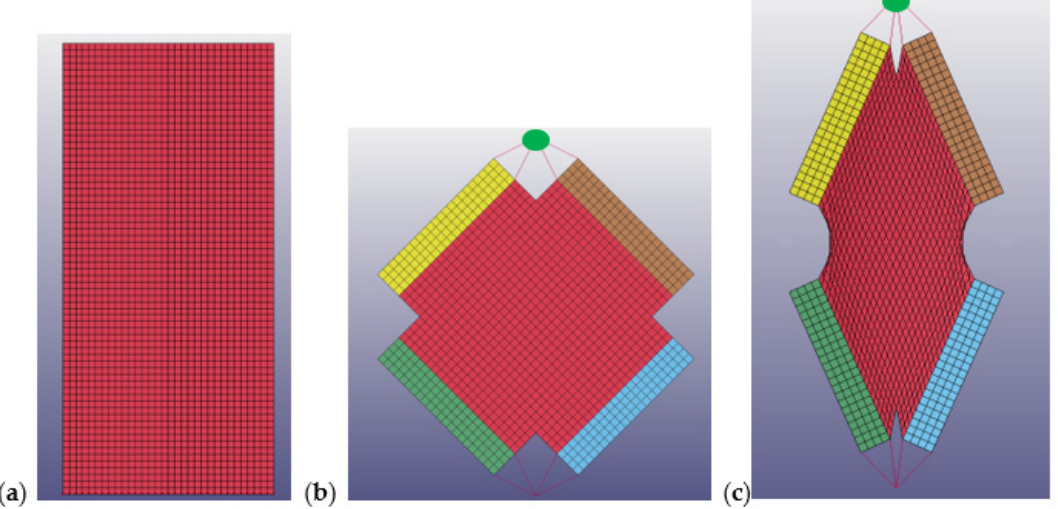
Figure 14. Virtual models of Tensile test ( a ) and Shear test: start point ( b ) and end point ( c ).